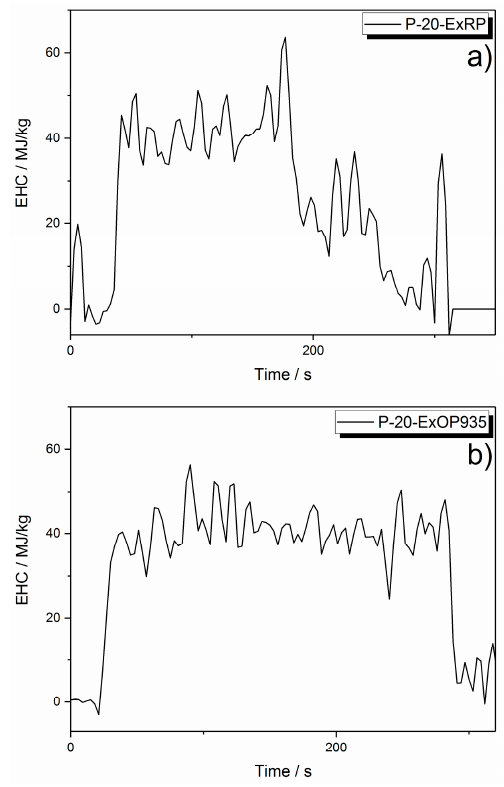
Figure 6. Effective heat of combustion: for P-20-ExRP exhibiting a two-part progression ( a ); and for P-20-ExOP935 as an example for a constant EHC ( b ).